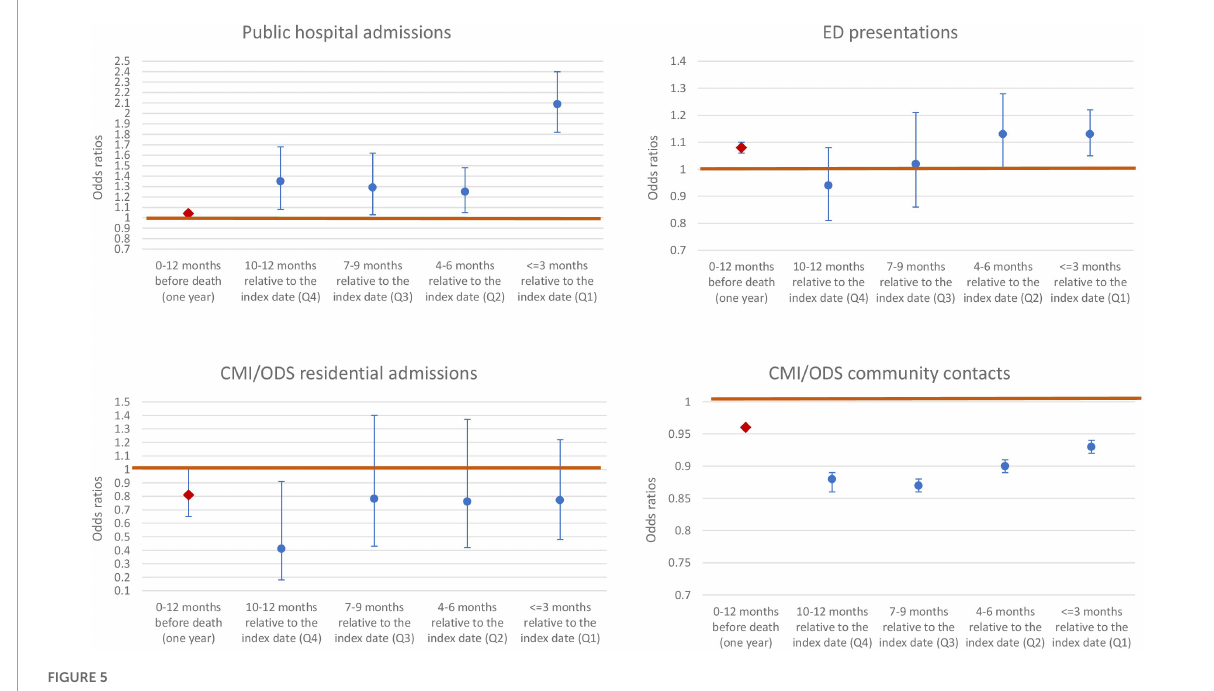
FIGURE5 Odds ratios with 95% confidence intervals by contact